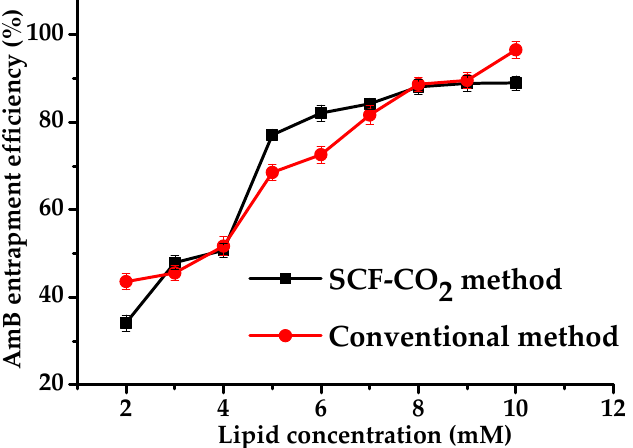
Figure Figure 4. Encapsulation efficiency of liposomal AmB prepared by the SCF-CO 2 and conventional methods.